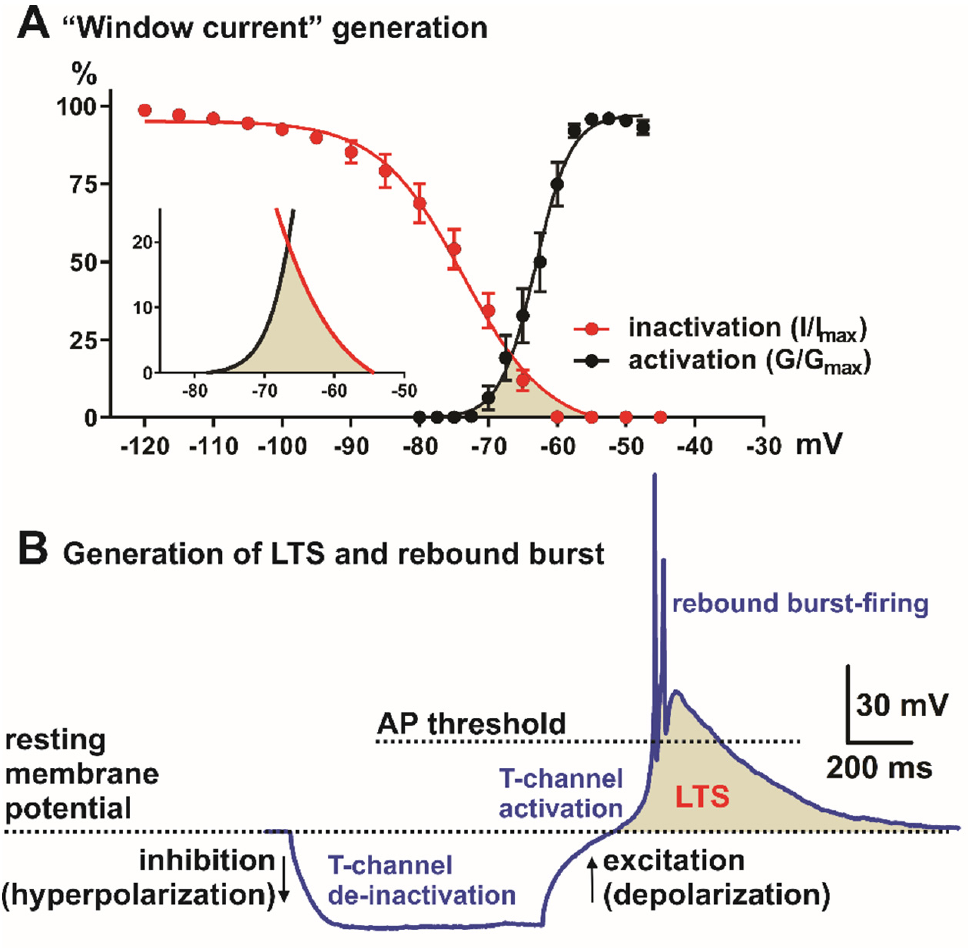
Figure 1. Neuronal Tchannel properties in the nonspecific thalamic nucleus (CeM). ( A ) “Window” current generation, red trace—steady-state inactivation and black—steady-state activation T-channel kinetics (from voltage-clamp experiments). Inset in A is enlarged “window” current (shaded area) generated by overlap between steady-state activation (black) and inactivation (red) curves. ( B ) Role of the T-channels in LTS (low-threshold spike, shaded area) and rebound burst generation. Note that in most systems, LTS and burst-firing cannot be generated from the resting membrane potential, but neurons need hyperpolarization of the cell membrane in order to allow T-channel de-inactivation (recovery from inactivation). AP—action potential.